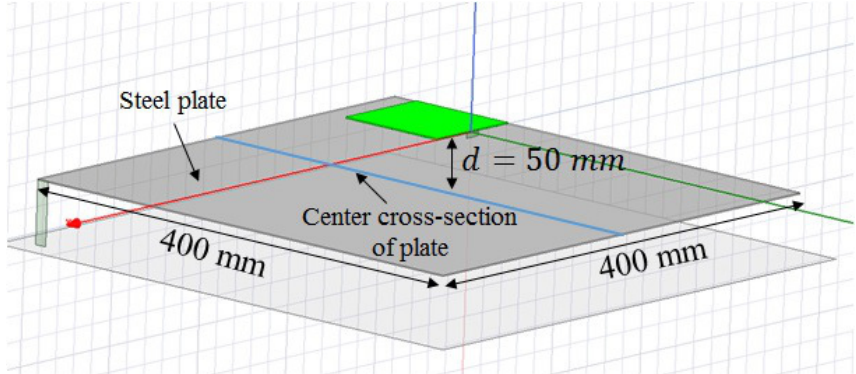
Figure 10. HFSS simulation setup of magnetic field probe with d = 5 cm.